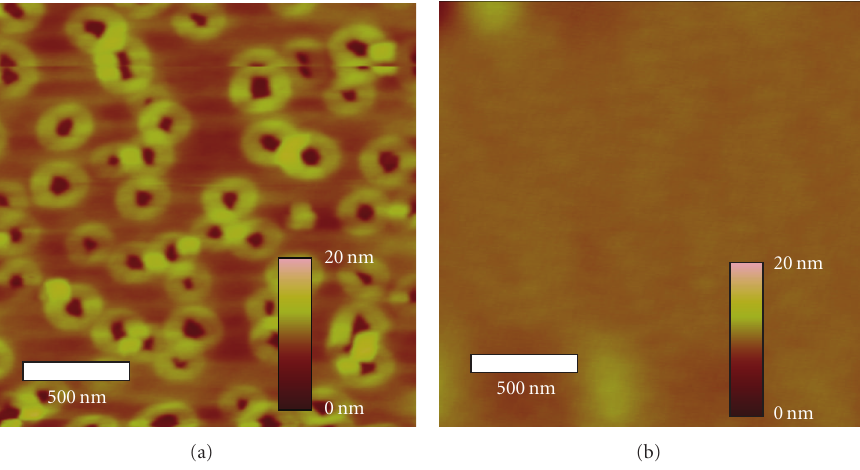
Figure 5: AFM images of the PMMA films over glass substrates with a thickness of (a) 9nm, which corresponds to I-V ohmic response and (b) 15nm, which corresponds to I-V response with two ON states.